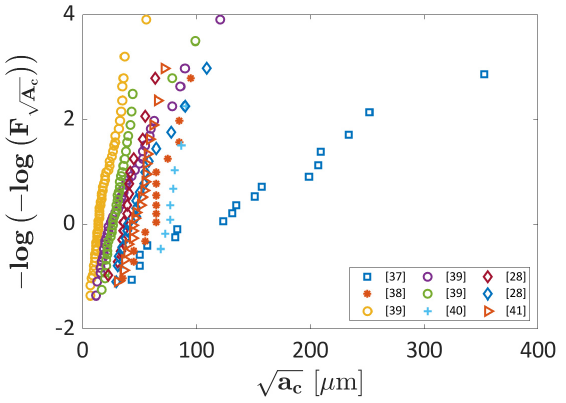
Figure 12. Ti6Al4V datasets considered for training and validating the developed ML algorithms on a Gumbel plot.